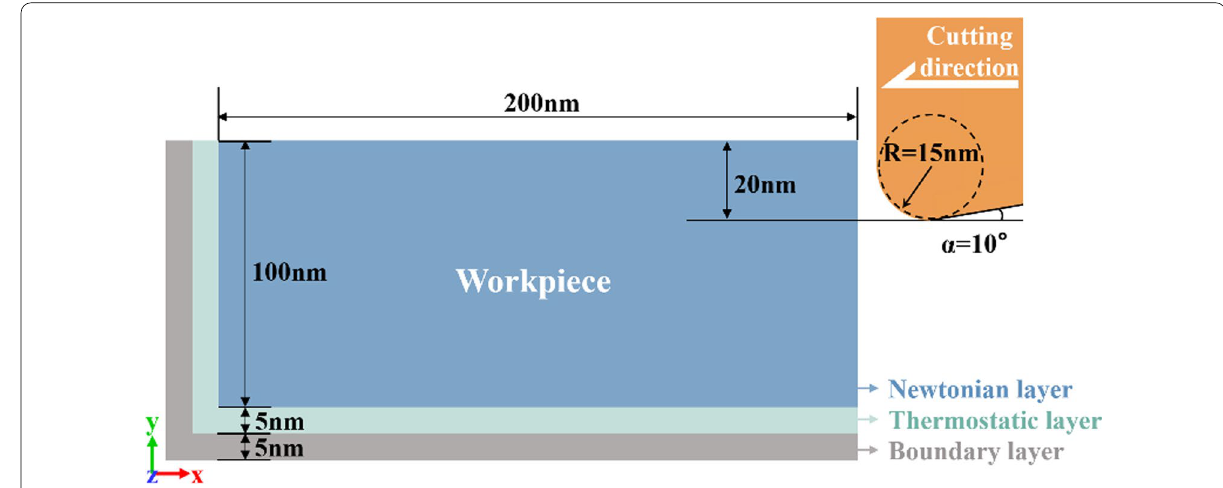
Fig. 5 Nano-cutting model